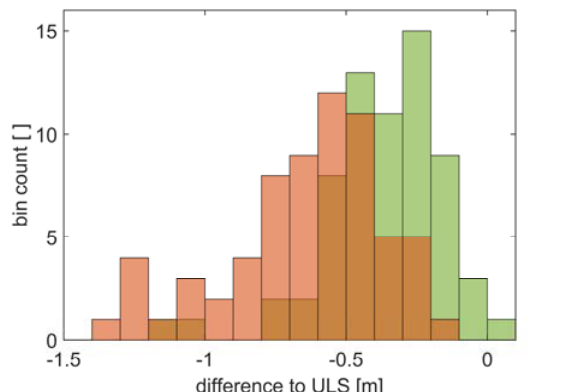
Figure 6. Histogram of penetration depth for trees; red: ULS to ALS; green: ULS to ALB; brown: transparent overlaying of smaller value Figure 8. Differences of estimated shrub heights from ULS to ALS (red) and ULS (green).